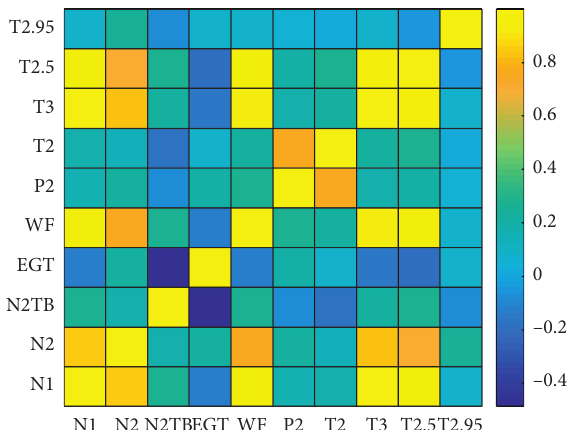
N1 N2 N2TBEGT WF P2 T2 T3 Figure 8: The mean of standard DCCA coefficients for the time series of aeroengine system gas path parameters.